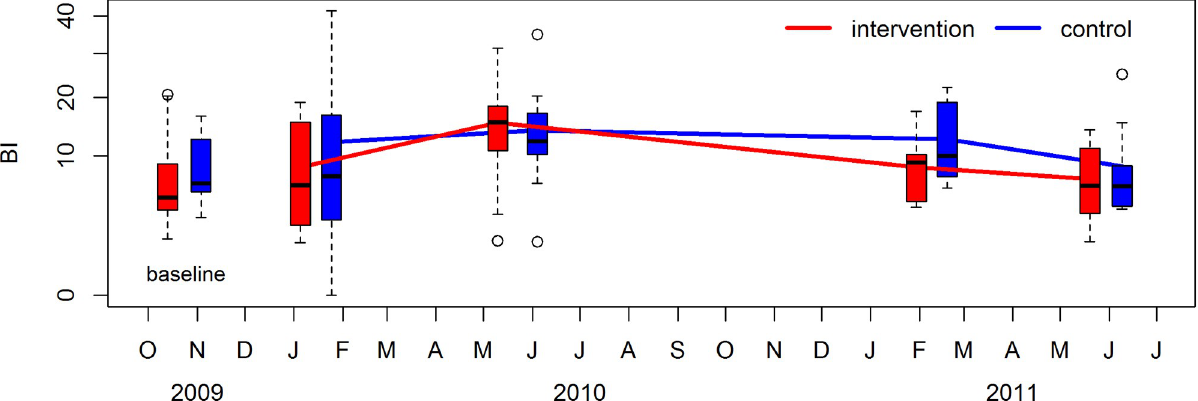
Fig 4. The Breteau Index, with results from intervention clusters shown in red and control clusters shown in blue. Boxes in the intervention period are joined by lines. The upper and lower limits of each box are the interquartile range across clusters. Each ‘whisker’ (dashed line) extends to the most extreme data point which is no more than 1.5 times the interquartile range from the box. Circles represent values which are more extreme than the whiskers. The baseline data are represented by the boxes corresponding to October/November